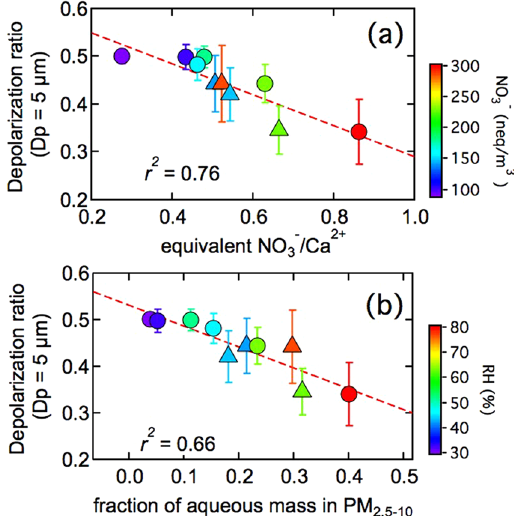
Figure 3. Relationship between the depolarization ratio of dust particles (Dp = 5 μ m) and equivalent ratio of NO 3 − /Ca 2 + ( a ) and the mass fraction of aqueous matter in the coarse mode ( b ). The colored circles in the plot represent the data during dust impact period from March 28 to April 1, 2015. The standard deviation (error bar) of depolarization ratio of dust particle was calculated for the dataset corresponding to filter sampling period. The color triangles indicate another weak floating dust case from April 9 to April 11, 2015. The backward trajectory analysis using HYSPLIT indicated that the air mass also came from northwest. Although none of the same dust plume was observed, the impact of anthropogenic pollutants on the depolarization ratio of the dust particle was similar.